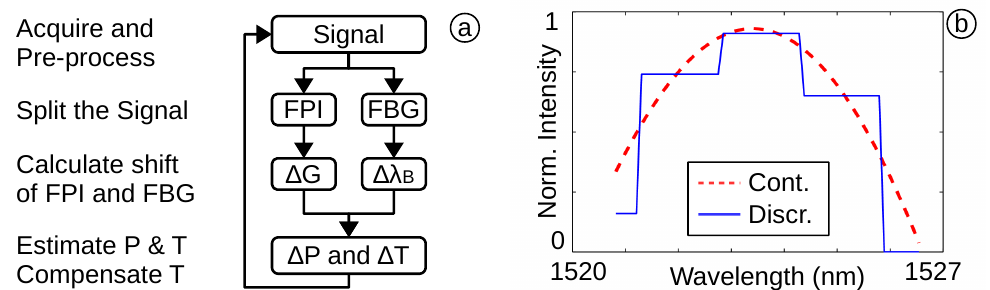
Figure 3. ( a ) The acquired spectrum is split into the FPI and FBG part; ( b ) an acquired FPI spectrum (continuous line) with 1 nm and the continuous optical spectrum pixel